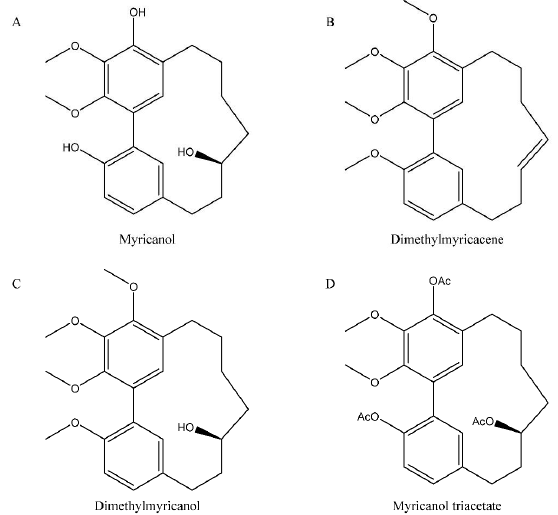
Figure 1. Chemical structure of myricanol and its derivatives. In the figure are reported the structures of myricanol derivatives: ( A ) myricanol, ( B ) dimethylmyricacene, ( C ) dimethylmyricanol and ( D ) myricanol triacetate.